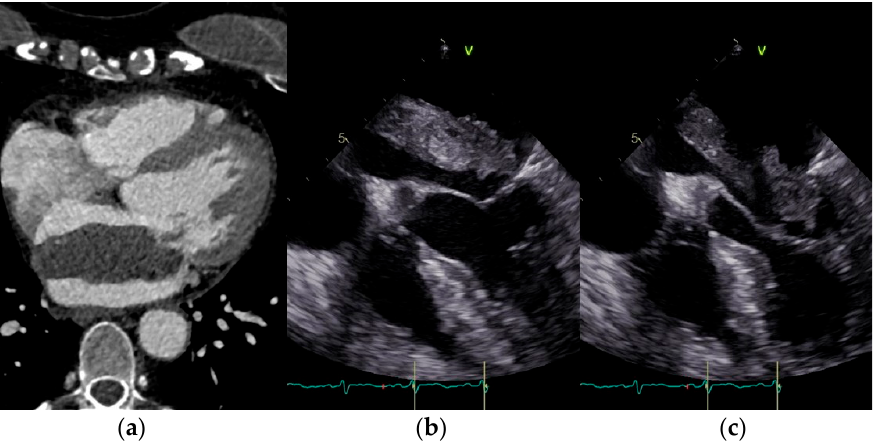
Figure 1 . ( a – c ) Exemplary CT and echocardiographic findings of a left atrial myxoma attached to the interatrial septum.